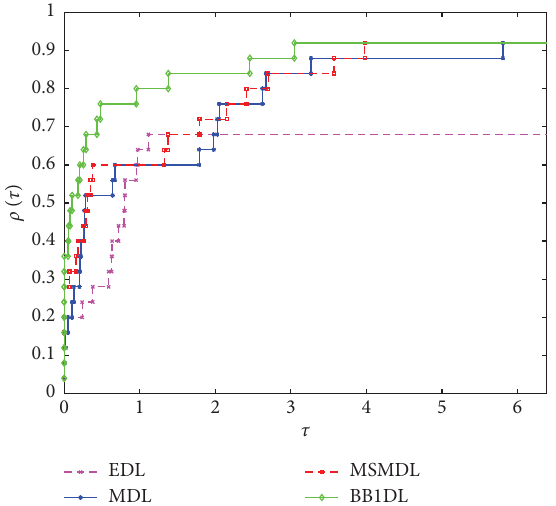
Figure 5: CPUts performance profles for EDL, MDL, MSMDL, and